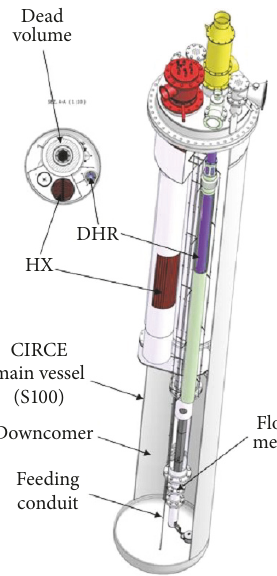
of Test 206. The region downward the two pins is evidenced by the stagnant and low velocity LBE, caused by the geo- metrical discontinuity. The latter region is also highlighted in Figure 9(b), where the velocity vectors coloured by axial velocity (along 𝑧 -axis) are reported.